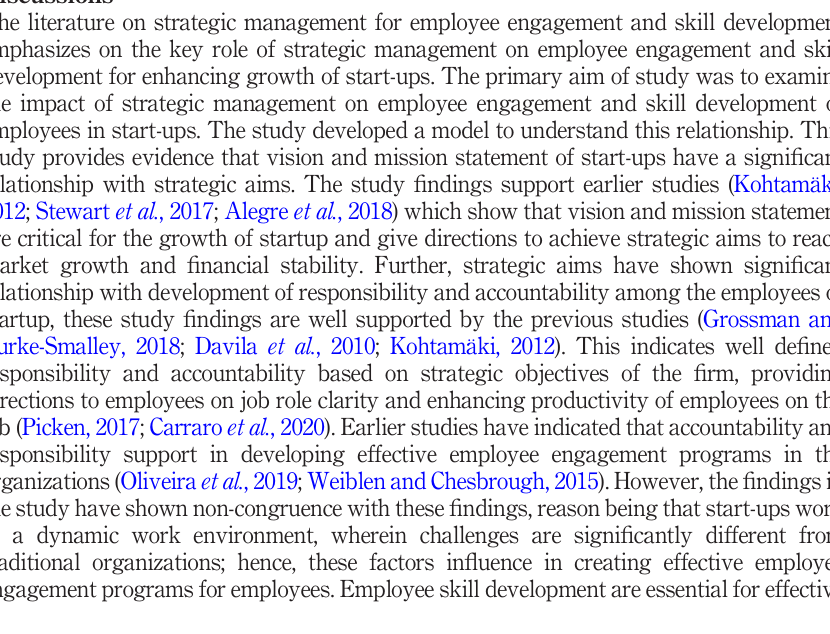
Table 7. Model summary – Regression